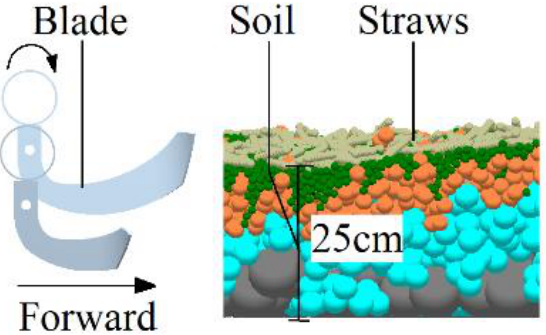
Figure 5. The discrete element model.